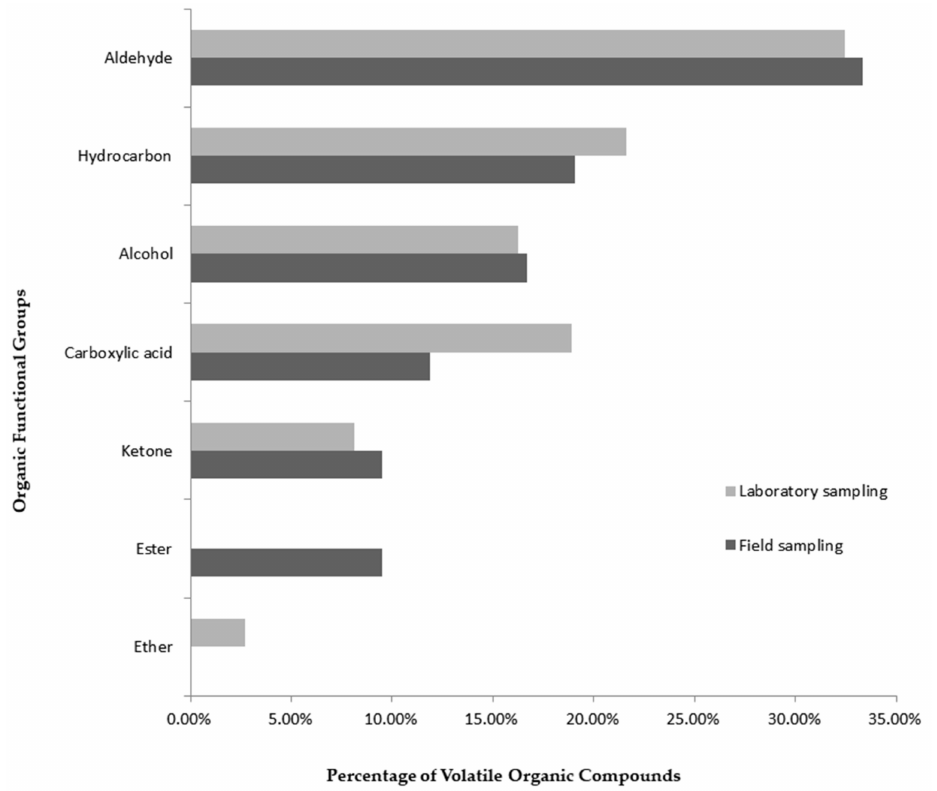
Figure 5. Comparison between the percentages of volatile organic compounds, distributed among seven di ff erent organic functional groups, obtained from the HS-SPME / GC-MS analysis of samples collected under laboratory and field